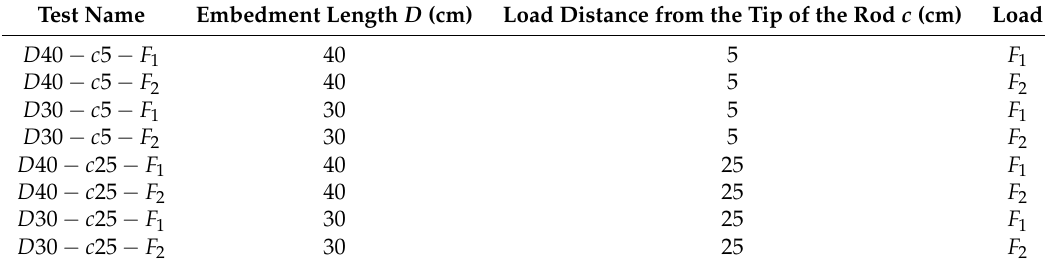
Table 1. List of static